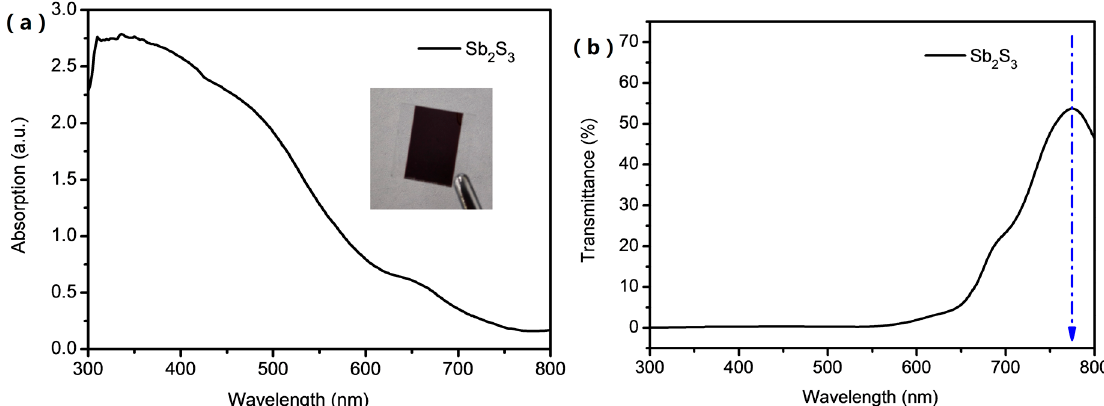
Figure 3. ( a ) UV-visible light absorption of the Sb 2 S 3 thin films (the inset picture is the sample of the evaporated Sb 2 S 3 thin film) and ( b ) transmittance spectrum of the Sb 2 S 3 thin film.